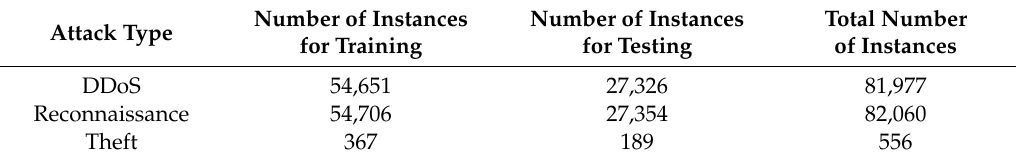
Table 3. The number of instances used in our experiment. DDoS, distributed